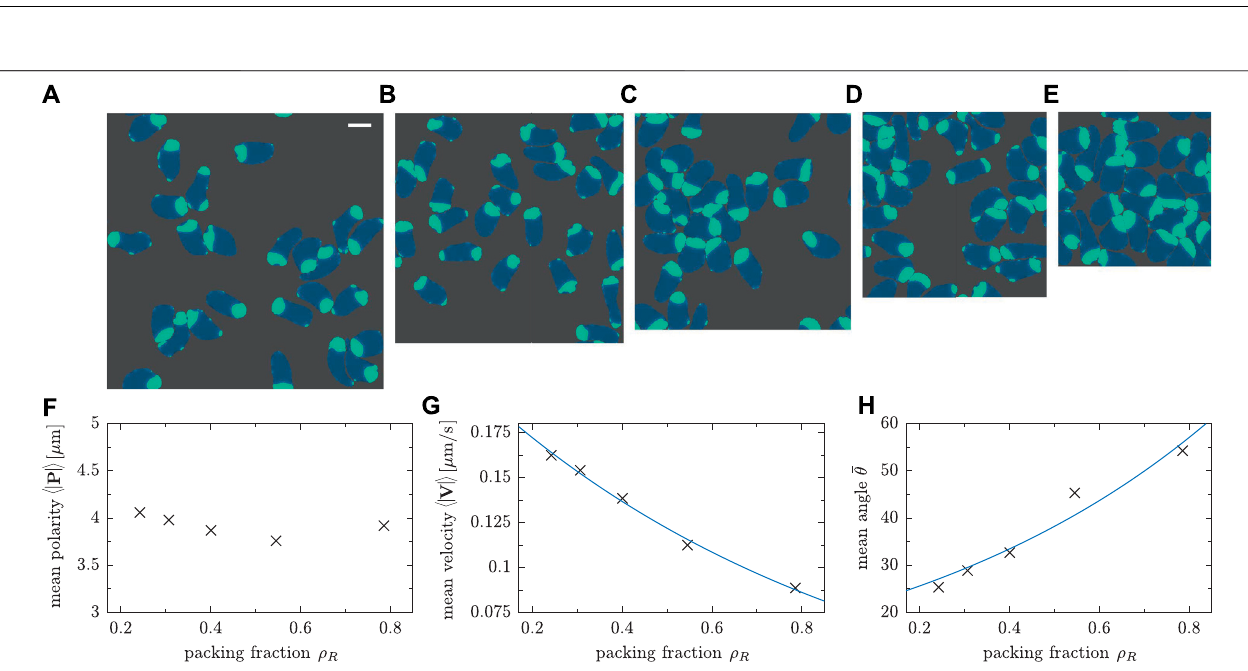
FIGURE 8 | Snapshots of simulations with constant cell number N = 25 and varying system size with a difference in side length of L = 12 μ m between consecutive panels. Thesidelength L ofthesimulation boxandthepackingfraction ρ R = NA 0 / L 2 are: (A) L =108 μ m and ρ R =0.24(MovieSM7); (B) L =96 μ m and ρ R =0.30; (C) L = 84 μ m and ρ R = 0.40; (D) L = 72 μ m and ρ R = 0.54; (E) L = 60 μ m and ρ R = 0.78 (Movie SM8). (F) Mean polarity, (G) mean speed and (H) mean angle between velocity and polarity for different packing fractions ρ R . The number of cells was fi xed ( N = 25 cells), while the system size was varied. The fi ts in panels (G) and (H) provide a guide to the eye.